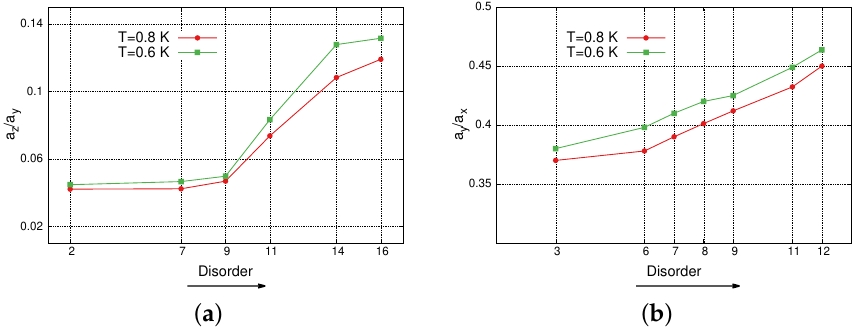
Figure 5. The dependence of aspect ratios a z / a y ( a ) and a y / a x ( b ) of superconducting domains in (TMTSF) 2 ClO 4 on disorder at two temperatures T = 0.8 K and 0.6 K, calculated using Equations (4), (9) and (10) and resistivity data from Figures 3 and 4 of Ref. [6], taken at cooling rate 600 K/min and various annealing times. At longer annealing time, i.e., at weaker disorder, the shape of SC domains is more